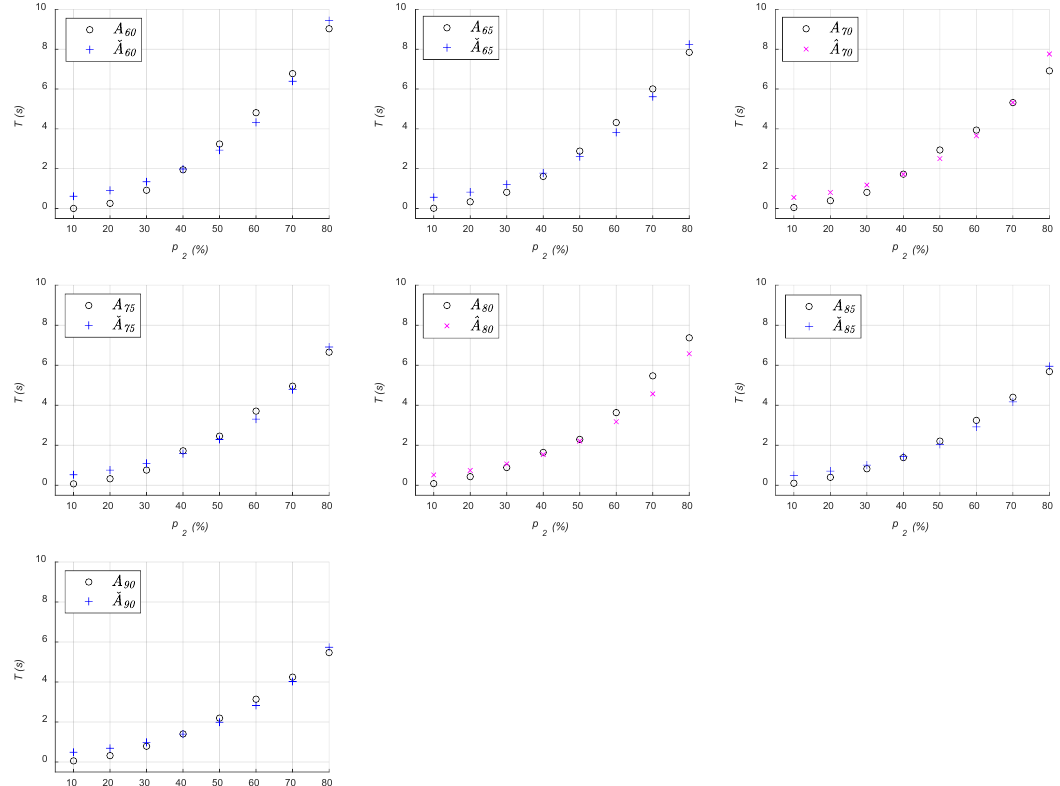
Figure 1. p 2 vs. T (procedure 1). vs. T (procedure 1). Figure 1. 𝑠𝑠 2